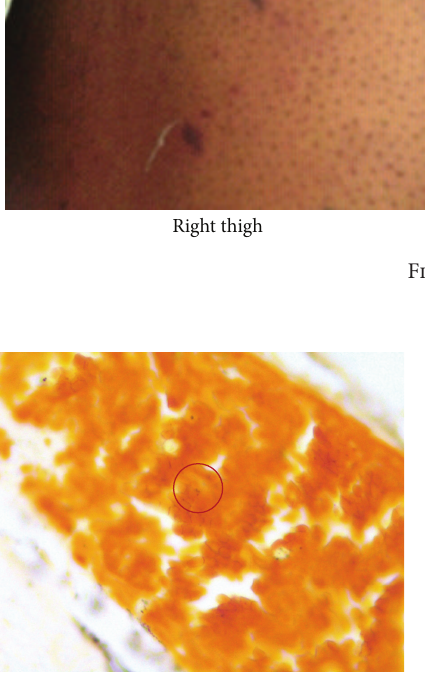
Figure 4: Skin biopsy, Steiner